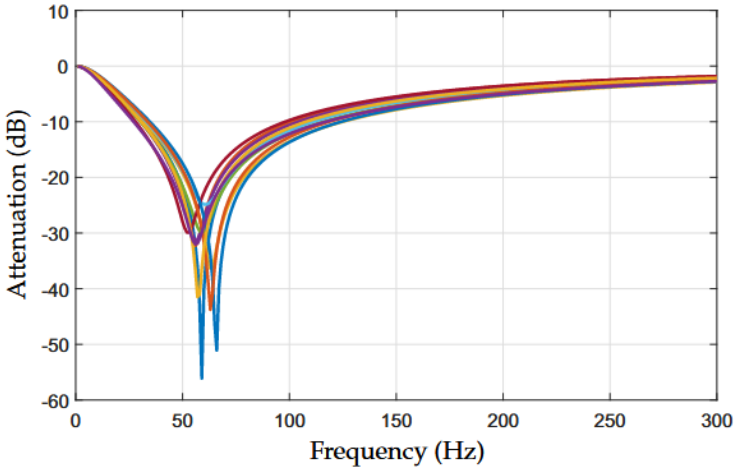
Figure 3. Numerical simulation of the attenuation of the twin-T notch analog filter for distinct deviations (up to ± 20 %) from the nominal values of components R 1 , R 2 , R 3 , C 3 , C 4 , and C 5